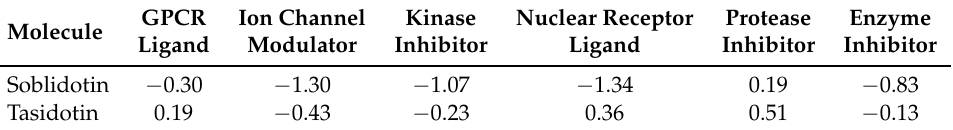
Table 4. Empirical Bioactivity Scores of the anticancer marine peptides, Soblidotin and Tasidotin. GPCR Molecule